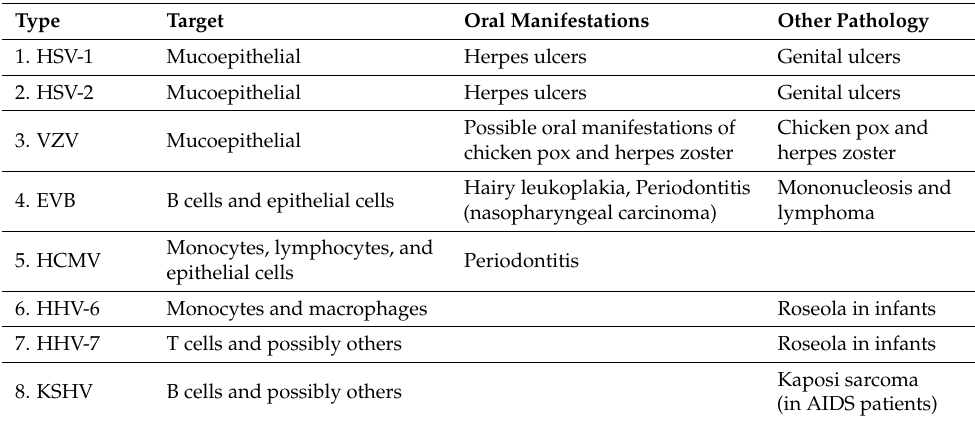
Table 1. Human herpesviruses (HHVs) and their associated